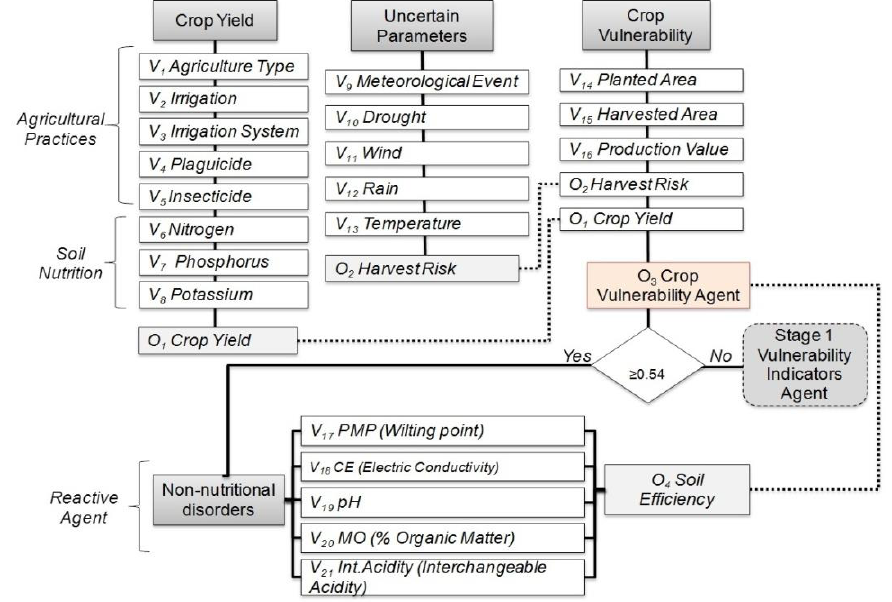
Figure 3. Crop vulnerability